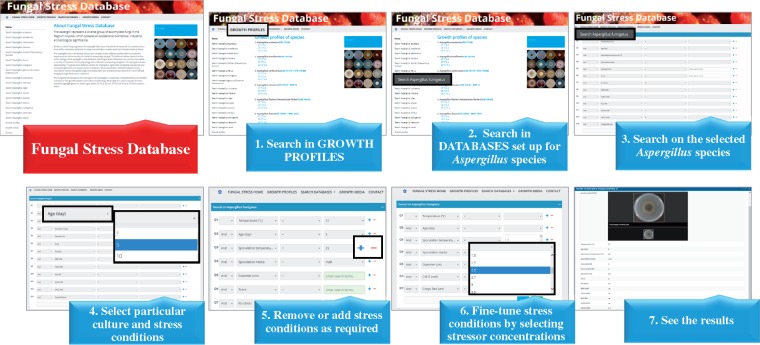
Search in the FSD.